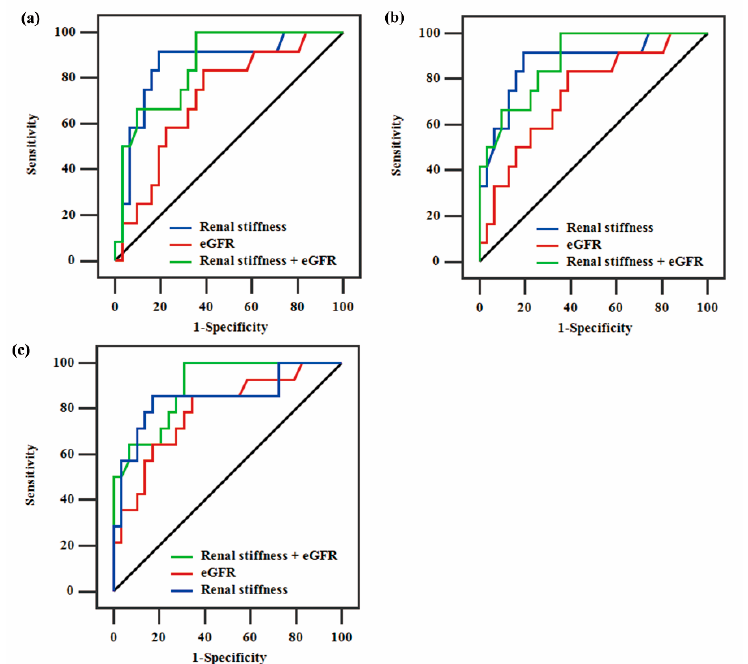
Figure 5. Graph showing receiver operating characteristic curves of p-SWE, eGFR, and p-SWE plus eGFR in the diagnosis of: ( a ) moderate-to-severe ci, ( b ) moderate-to-severe ct, and ( c ) moderate-to- severe IF/TA. Table 6. Diagnostic performance of p-SWE, eGFR, and p-SWE combined with eGFR in moderate-to- severe ci, ct, and IF/TA (Grade ≥